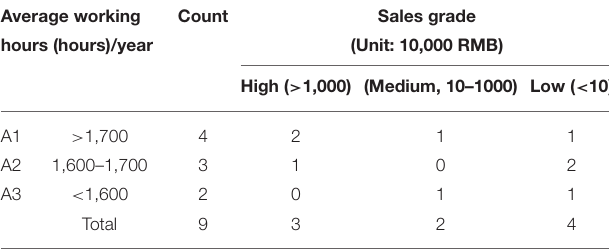
TABLE 4 | Analysis of average working hours and sales of smart beds.